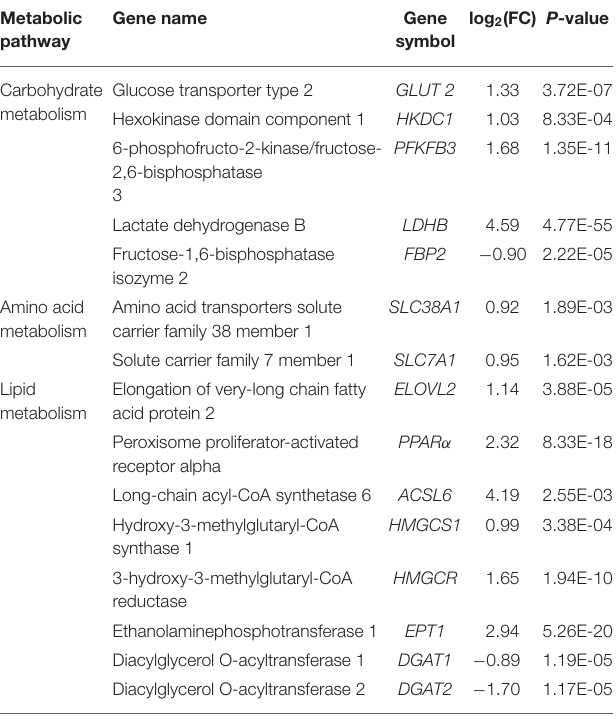
TABLE 4 | Most relevant genes affected by SPH infusion in the liver. Metabolic